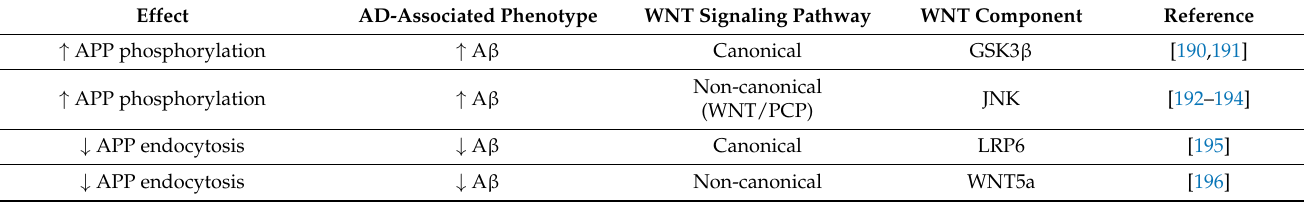
Table 1. Summary of the effects of components of the canonical and non-canonical WNT signaling pathways on AD-related processes and phenotypes. Arrows ( ↑ , ↓ ) in the table indicate an increase or decrease in the effect and AD-associated phenotype,